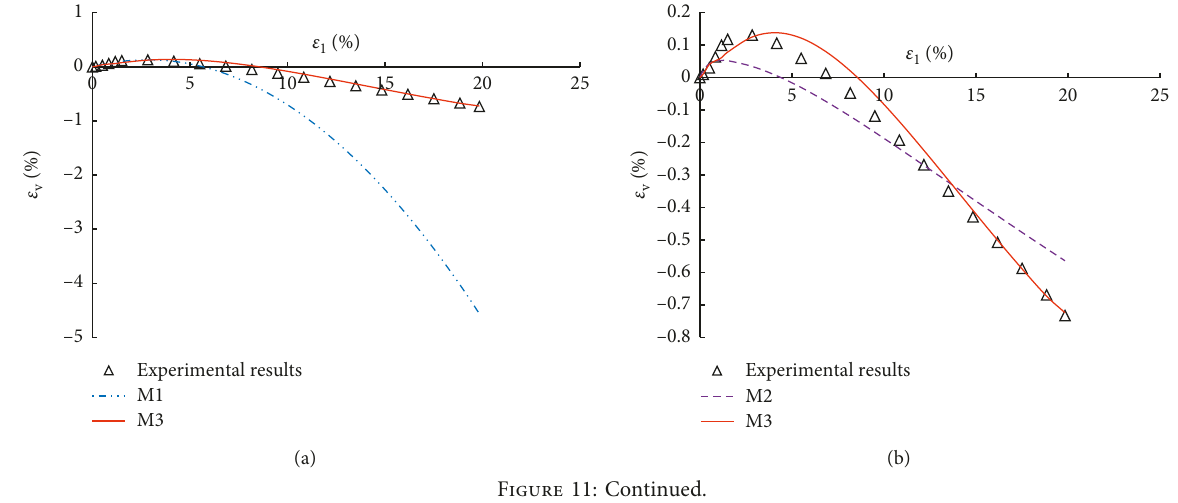
� 1.0MPa. (b) T � − 5 ° C, σ � 3 3